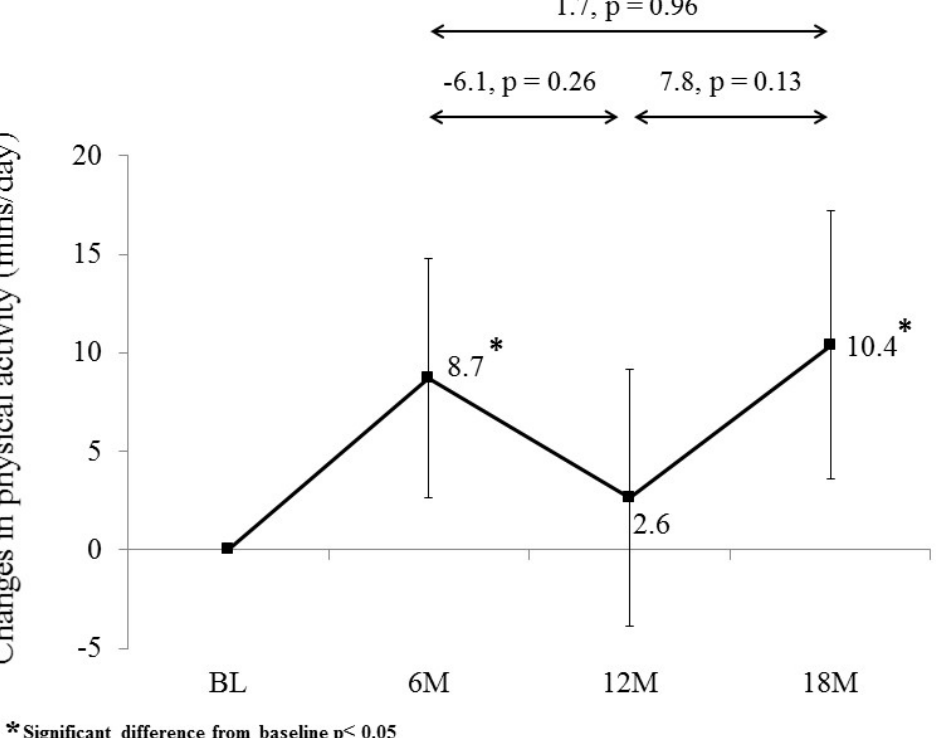
statistically significantly, during both the extended contact intervention (364 kJ/day [95% CI -609 to 1338]; 87 kcal/day [95% CI -146 to 320]; P =.735) and the no-contact follow-up (416 kJ/day [95% CI -620 to 1451]; 99 kcal/day [95% CI -148 to 347]; P